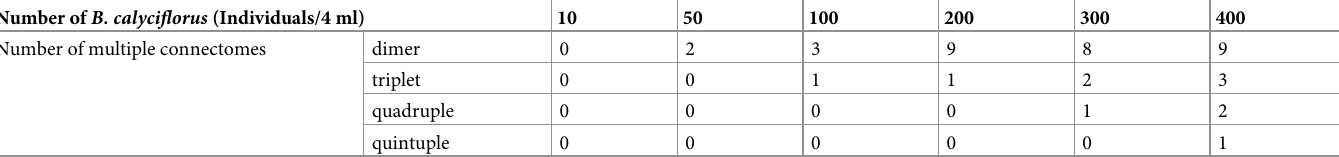
Table 1. Experimental results of correlation between density and linear aggregation. Number of B. calyciflorus (Individuals/4 ml) Number of multiple